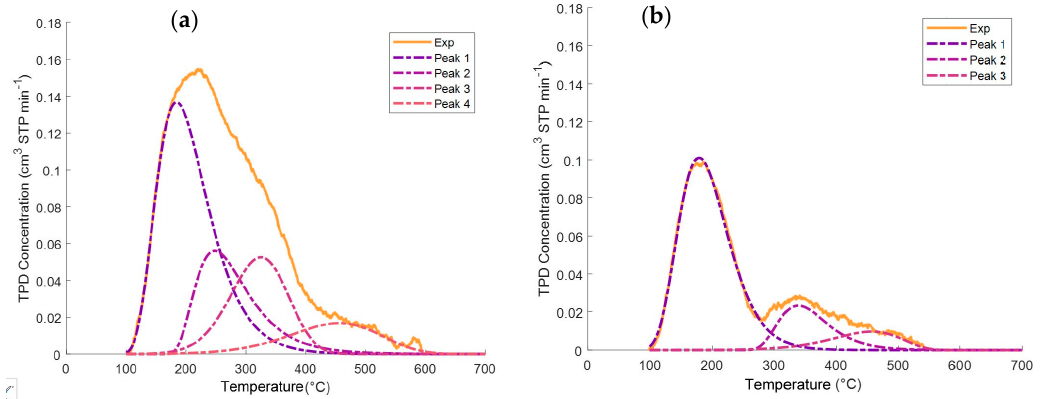
Figure 4. Deconvolution curves for ( a ) γ -Al 2 O 3 , ( b ) Fe x O y /10% CaO- γ -Al 2 O 3 .